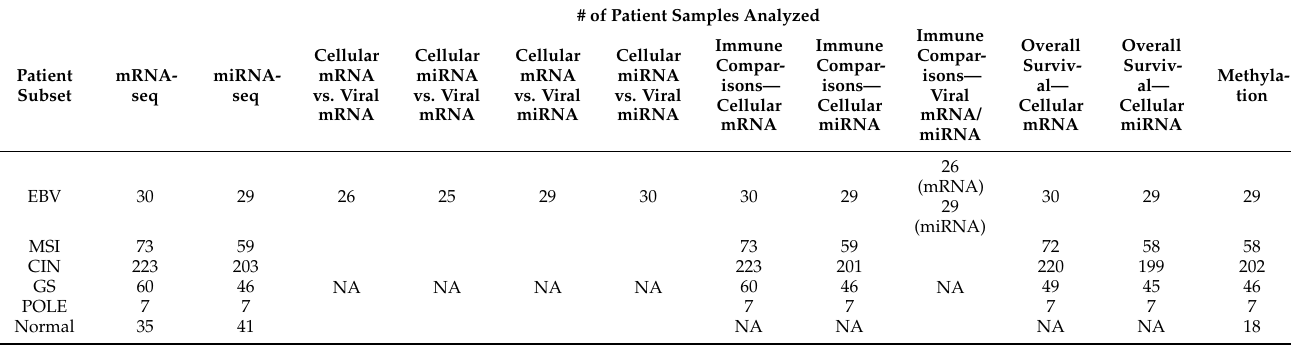
Table 1. Number of patient samples analyzed from the TCGA STAD cohort for each EBV-GCR tool, excluding the single-cell analysis